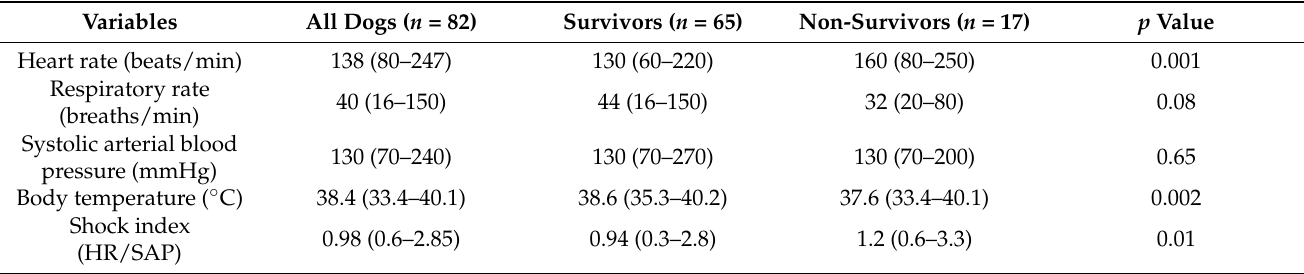
Table 3. Physical examination findings at arrival and their associations with death.